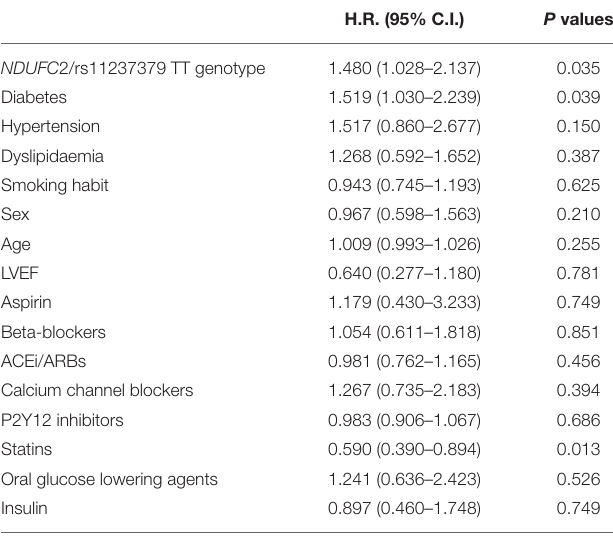
TABLE 3 | Predictors of ACS recurrence at follow-up by univariate analysis.